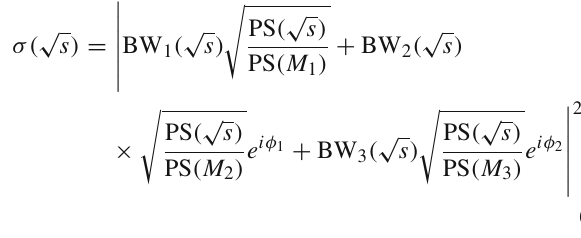
Fig. 2 Fit to the cross section of e + e − → π + π − J /ψ using three resonances. Four solutions are found and are shown in plots ( a ), ( b ), ( c ) and ( d ). The solid red curves show the best fits, and the dashed green ones are individual